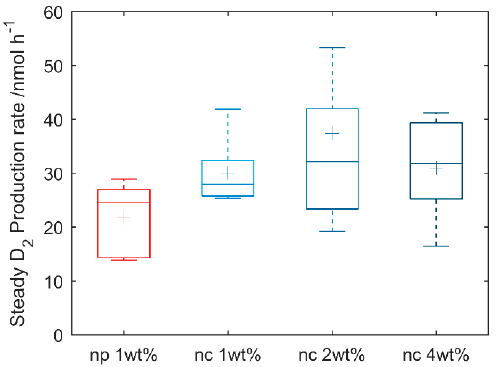
Figure 6. Box and whisker plots of steady D 2 production rate for photocatalysts tested.